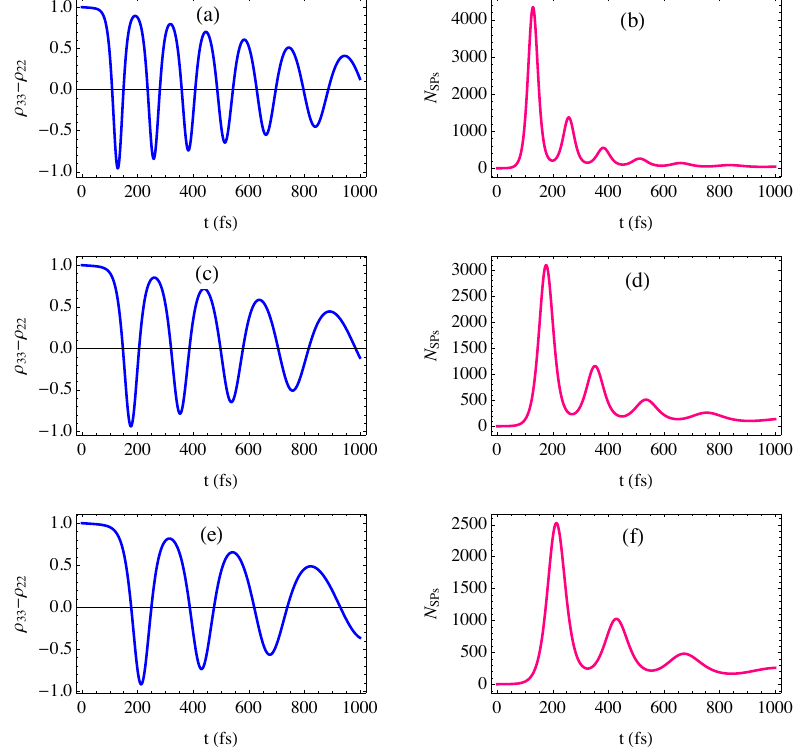
Figure 6. Ultrafast dynamics of the proposed MNPs-GNDs-QDs hybrid-system-based spaser: ( a , c , e ) the temporal behavior of the population inversion; ( b , d , f ) the time evolution of SPs population in the spasing mode of energy 41.5 meV with metallic width (a,b): W = 0.2 λ 0 , (c,d): W = 0.4 λ 0 and